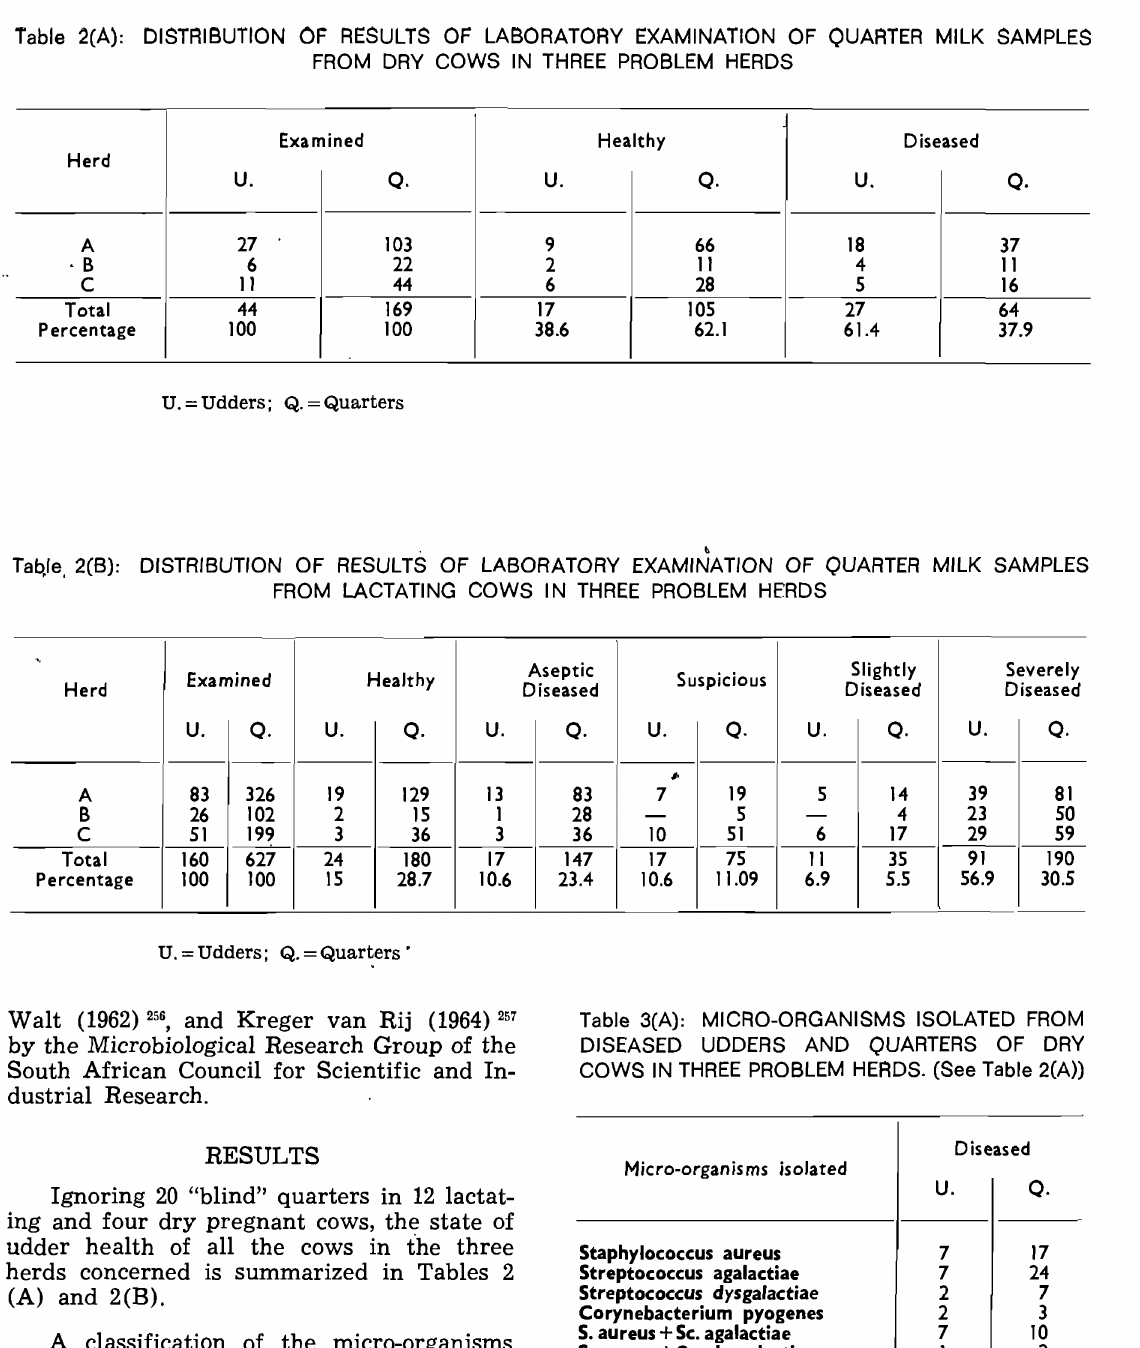
Table 2(A): DISTRIBUTION OF RESULTS OF LABORATORY EXAMINATION OF OUARTER MILK SAMPLES FROM DRY COWS IN THREE PROBLEM HERDS